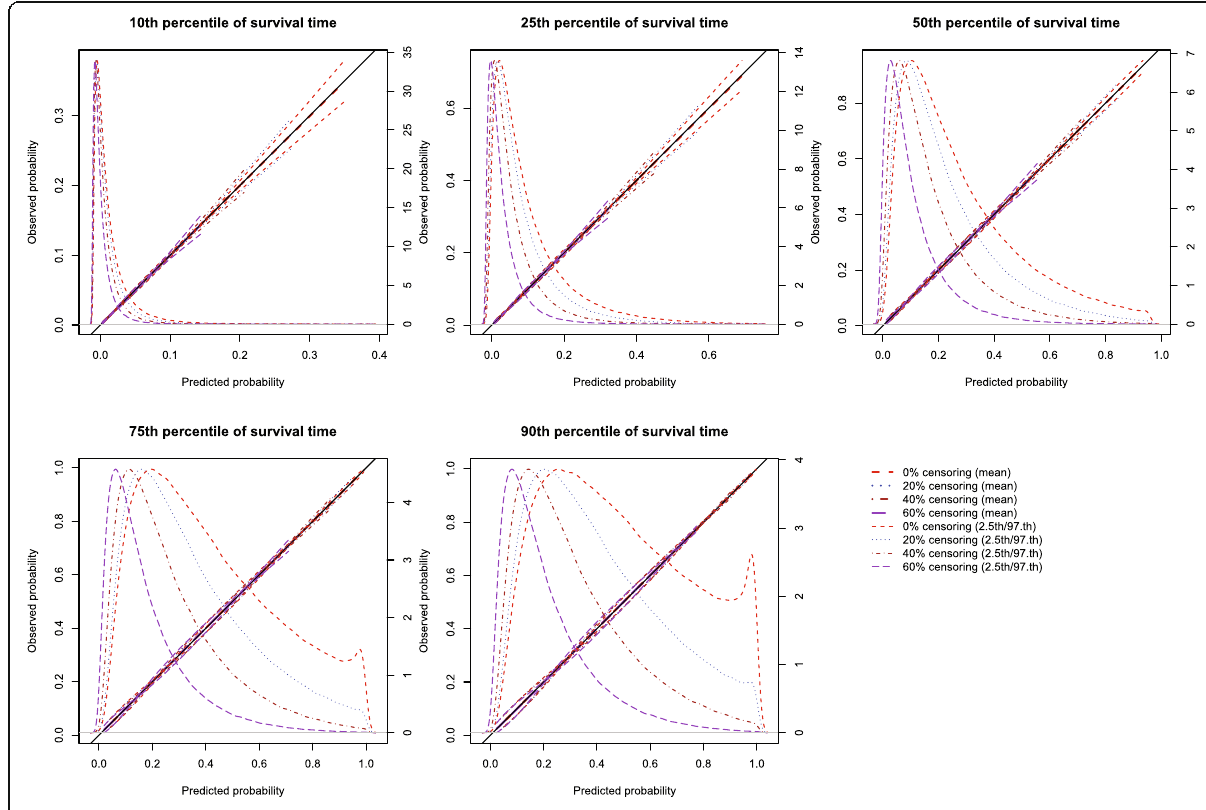
Fig. 3 Effect of degree of censoring on estimated calibration curves ( N = 2000 and p =